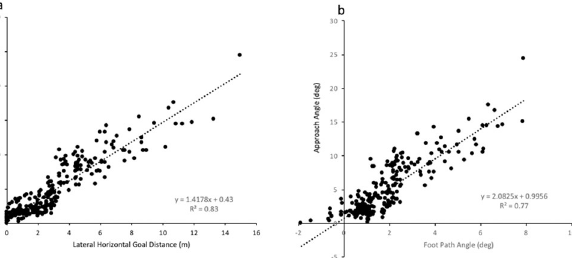
Fig 4. Relationship between (a) approach angle and accuracy (values to the right of the dashed indicate missed kicks) and (b) approach angle and foot-path angle.